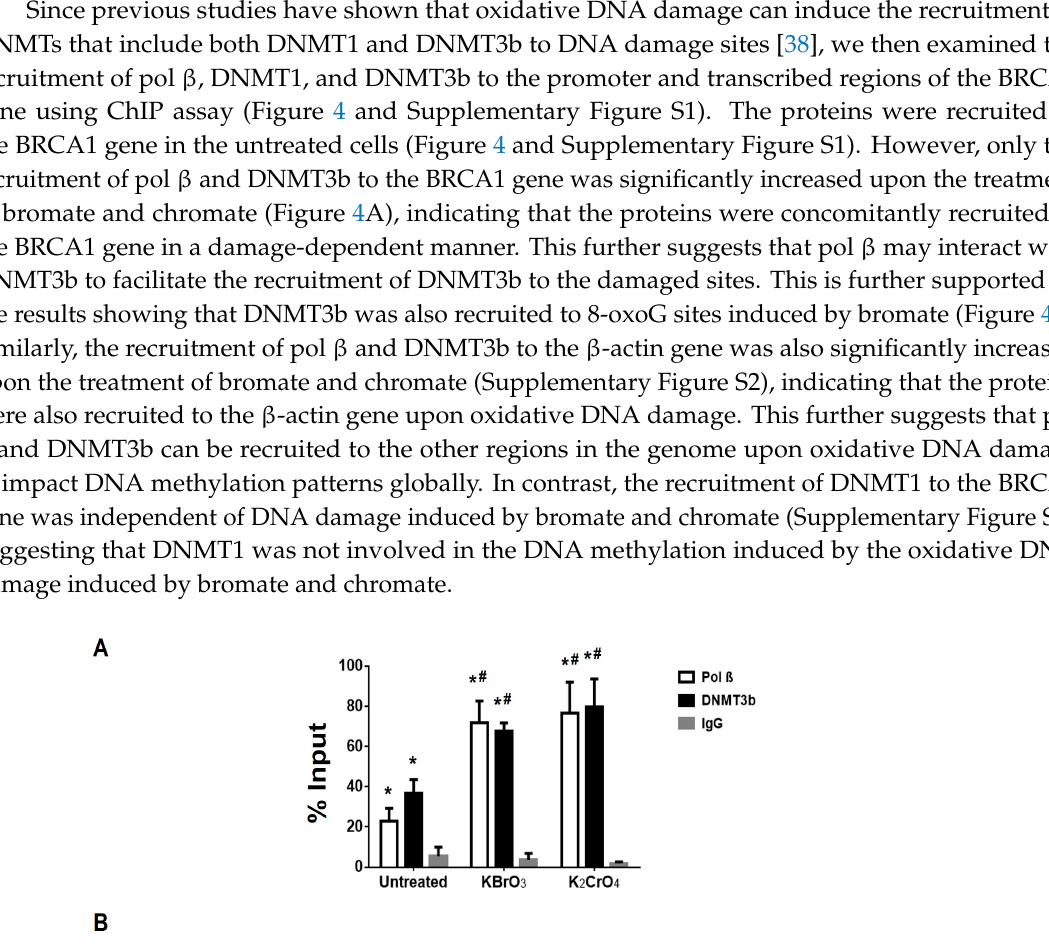
Figure 4. The recruitment of pol β and DNA methyltransferase 3b (DNMT3b) to the promoter and transcribed regions of the BRCA1 gene upon oxidative DNA damage: ( A ) The recruitment of pol β and DNMT3b to the promoter and transcribed regions of the BRCA1 gene was detected by Chromatin Immunoprecipitation (ChIP) assay as described in the Materials and Methods section. The quantification of the amount of DNA that represents the amount of pol β and DNMT3b recruited to the regions of the BRCA1 gene in the untreated cells and cells treated with 5 mM bromate or 10 µM chromate was shown. The “% Input” was calculated using the following equation: Input % = 2 −Δ Ct (normalized ChIP) × 100. The results were obtained from three independent experiments and illustrated as mean ± S.D. Two-way ANOVA with Tukey’s multiple comparison posttests was used to determine statistically significant differences. “*” denotes P < 0.05 compared to the IgG control, and “#” denotes P < 0.05 compared with the untreated cells. ( B ) The recruitment of DNMT3b to 8-oxoGs in cells was detected using immunofluorescence and confocal microscopy. 8-oxoGs (red) induced by 5 mM bromate for 2 h was stained by the same anti-8-oxoG antibody as the one shown in Figure 3.